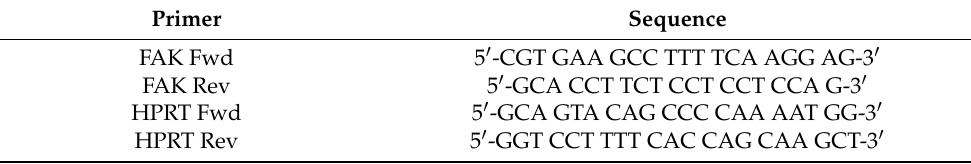
Table 1. Primers used for